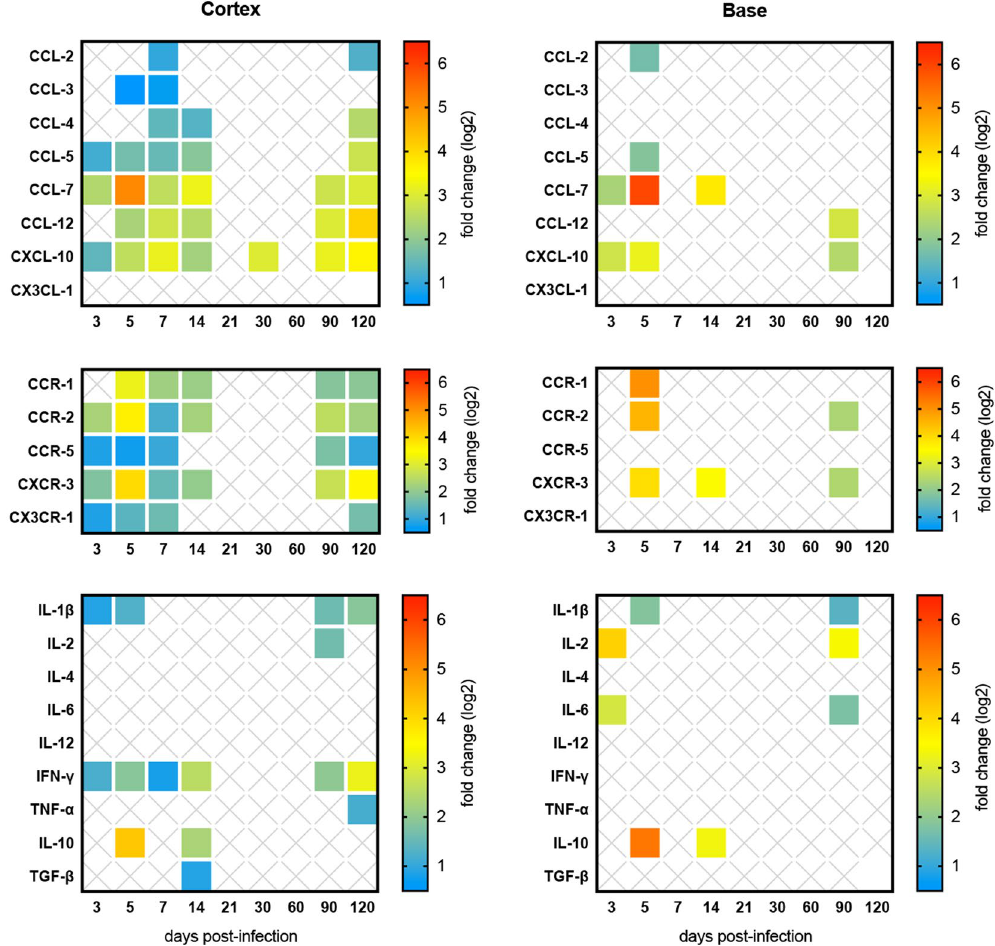
Figure 4. Inflammatory response assessment of BALB/c mice brains infected with Leishmania donovani . Relative gene expression of chemokines, chemokine receptors and cytokines in the cortex (left panel) and in the base (right panel). The results are expressed as fold change (up-regulation) for each time point post infection. Full-colored squares represent significant fold changes (P <